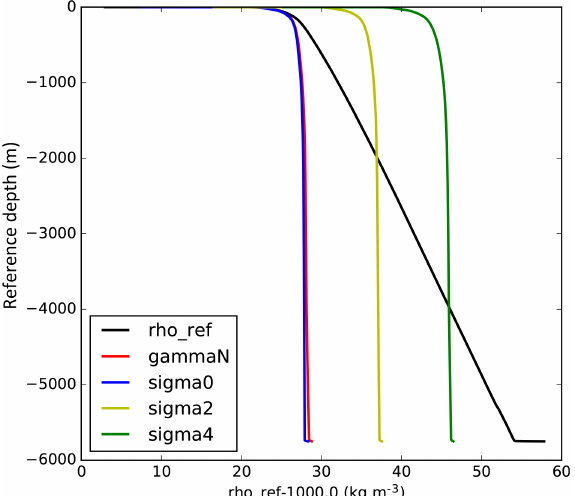
Figure 2. Reference density for ρ ref (black), γ n (red), σ 0 (blue), σ 2 (yellow) and σ 4 (green) as a function of the reference depth.